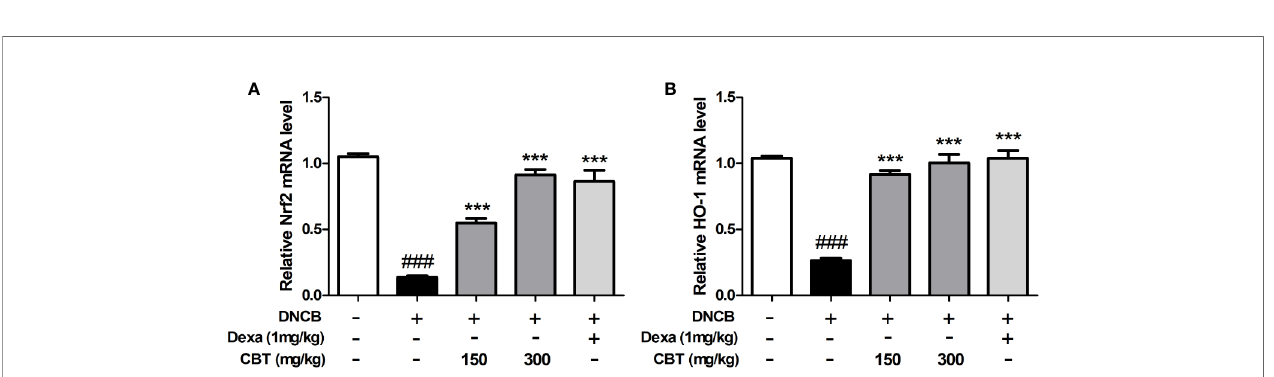
FIGURE 6 | Effects of Chijabyukpi-tang (CBT) on the mRNA expression level of HO-1 in DNCB-treated mice skin tissues. The mRNA expression levels of Nrf2 (A) and HO-1 (B) were analyzed using the quantitative real-time polymerase chain reaction (qPCR). Data are shown as mean ± SEM of the three independent experiments. ### p < 0.001 compared with the normal group, ***p < 0.001 compared with the DNCB-treated group. The Dexa group was set as positive